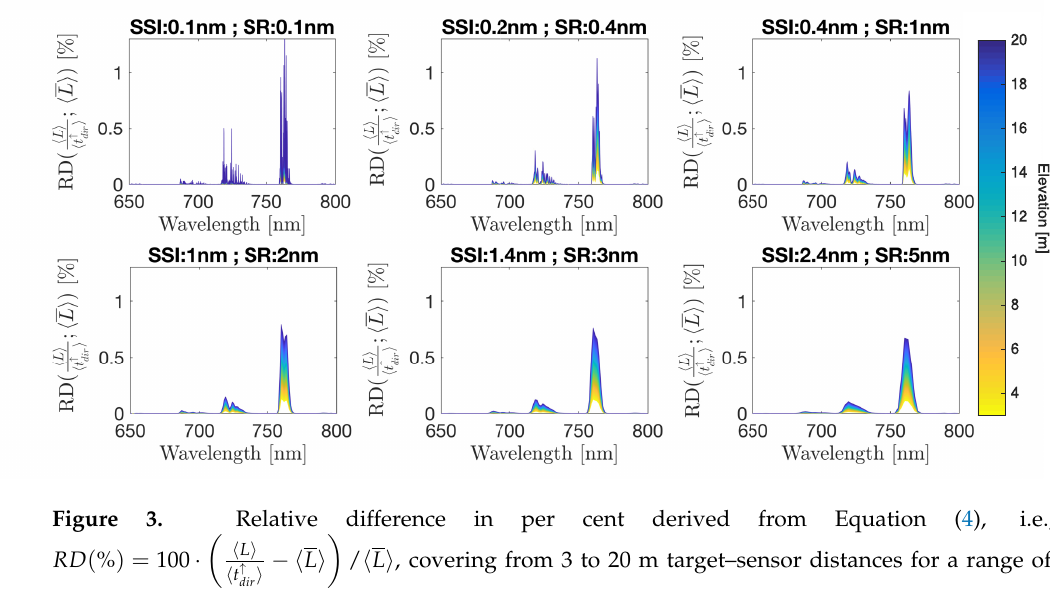
Figure 3. Relative difference in per cent derived from Equation (4), i.e., (cid:18) (cid:19) (cid:104) L (cid:105) − (cid:104) L (cid:105) RD ( % ) = 100 · / (cid:104) L (cid:105) , covering from 3 to 20 m target–sensor distances for a range of (cid:104) t ↑ (cid:105) dir Spectral Resolution (SR) and a Spectral Sampling Interval (SSI), as indicated in each